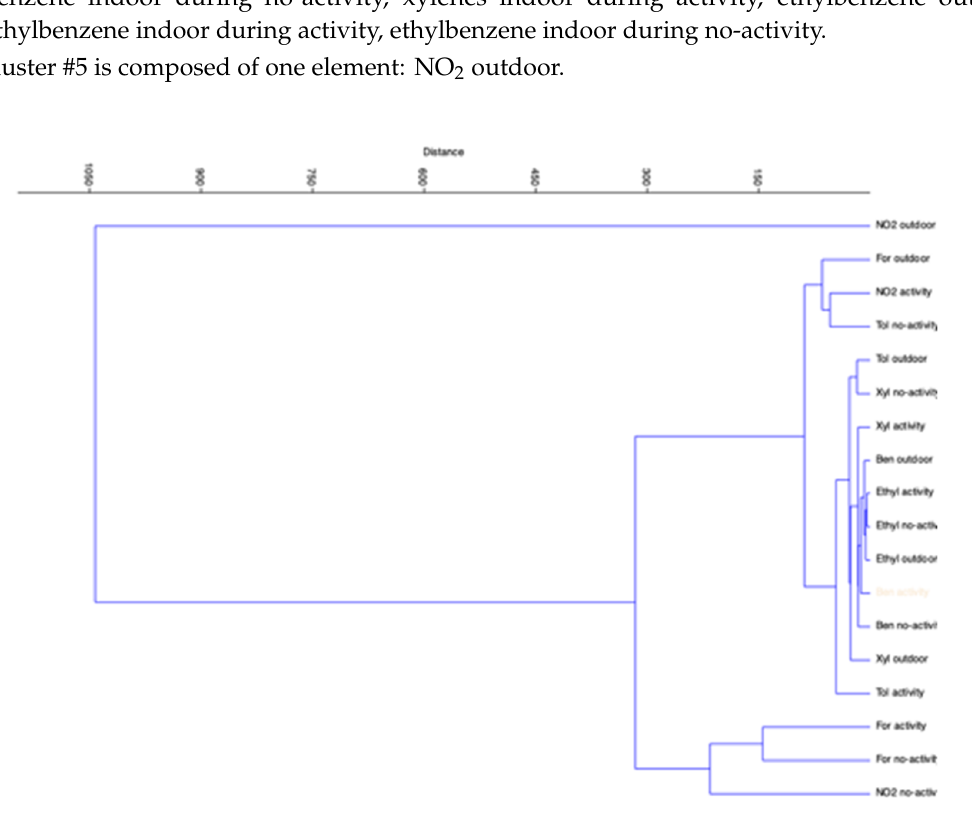
Figure 5. Cluster analysis related to compounds sampled in different situations in the eight schools.